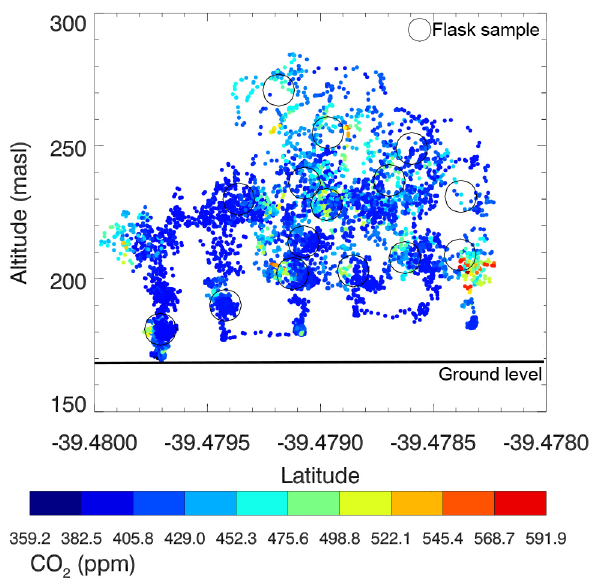
Figure 2. Measured CO 2 mole fraction across transect from south to north. Large black circles indicate the flask sampling